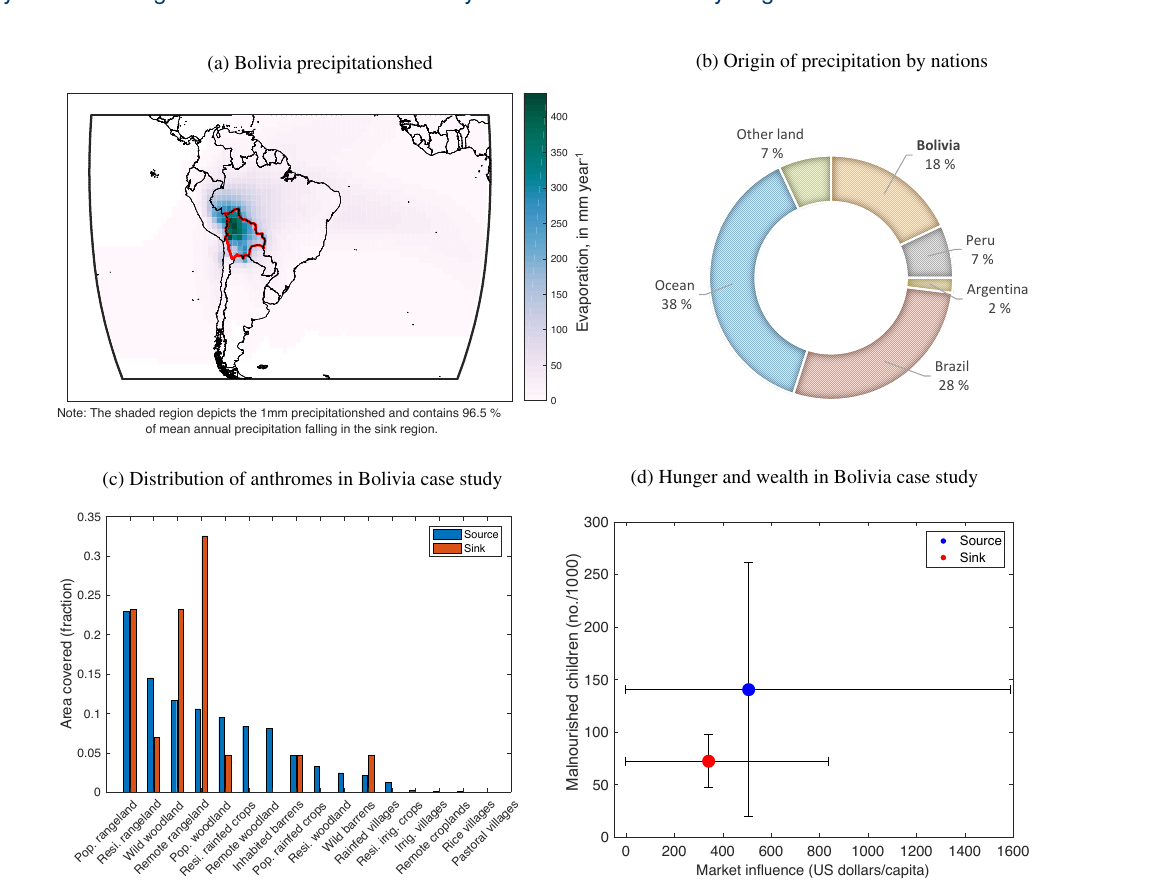
Figure 4. Bolivia case study including (a) precipitationshed analysis, (b) key source countries, (c) comparison of land uses between the country and its precipitationshed, and (d) comparison of economic and food security aspects of country and source regions.